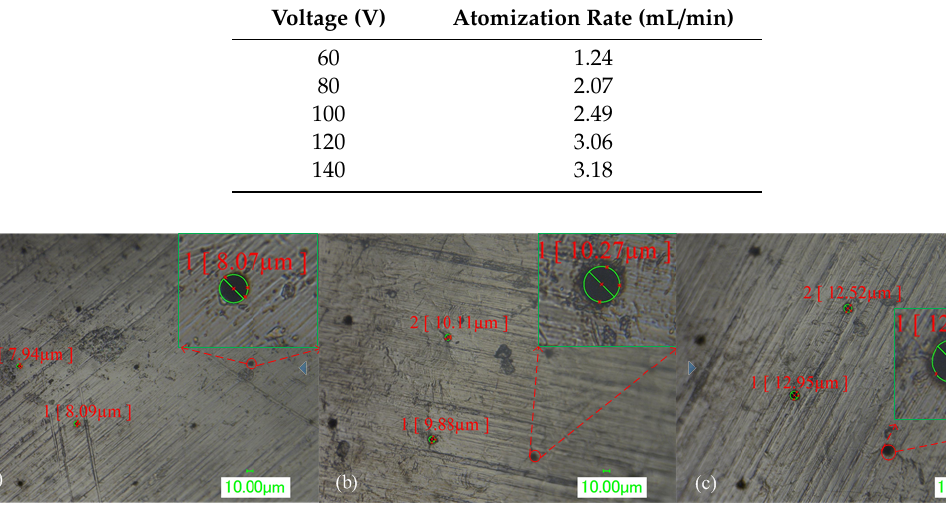
Figure 11. Outlet diameters of the micro-tapered apertures. Appl. Sci. 2020 , 10 , x FOR PEER REVIEW